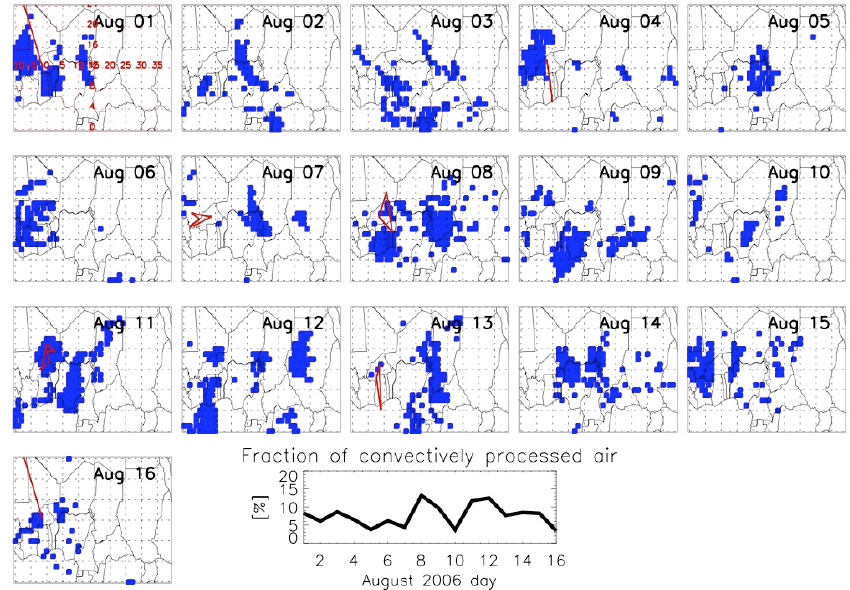
Fig. 8. Daily maps of convective impact at 200hPa level derived from the percentage of trajectories passing over convective systems diagnosed from MSG cloud tops over the West African domain (blue points, see text for details). M55 flight paths are displayed for the days flights took place. Also shown (inset, bottom right) is an estimate of the fraction of convectively processed air for the West African region. Only grid points where at least 5% of trajectories have been “processed” by convection were used in the calculation of the average.